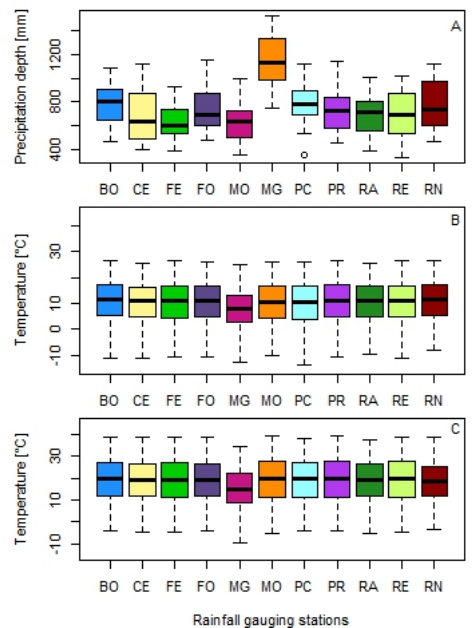
Figure 2. A Boxplots of the historical: ( A ) rainfall recorded over 27 years (1990–2016); ( B ) Minimum daily air temperature, and ( C ) maximum daily air temperature over 12 years (2005–2016) for the 11 cities in Emilia Romagna Region